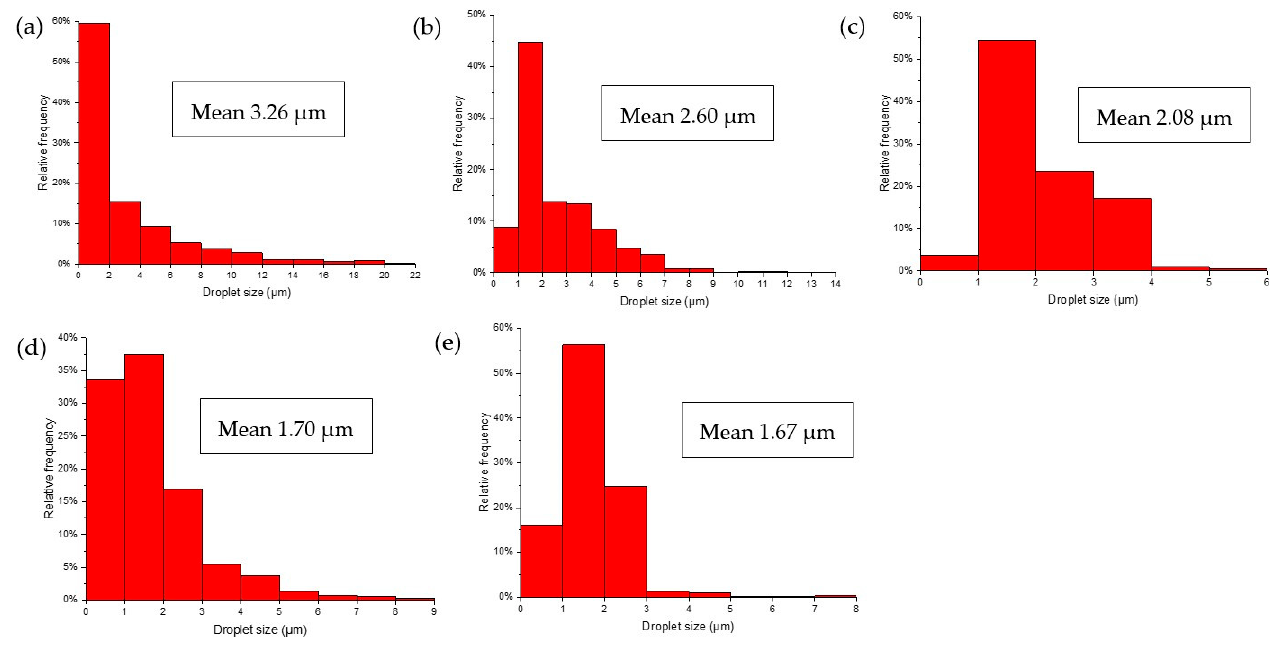
Figure 4. Droplet size distribution of lemongrass essential oil loaded emulsions stabilized by TEMPO-CNF at varying concentrations of ( a ) 0%, ( b ) 0.1 wt%, ( c ) 0.3 wt%, ( d ) 0.5 wt%, and ( e ) 0.7 wt% TEMPO-CNF (corresponding to microscopy images in Figure 3).